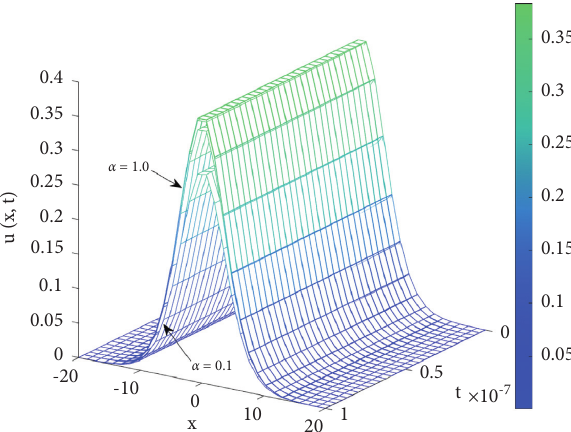
Figure 1: 3D fractional temporal numerical solution u ( x,t ) for order α ∈ ( 0 , 1 ] , κ � 4, and δ �